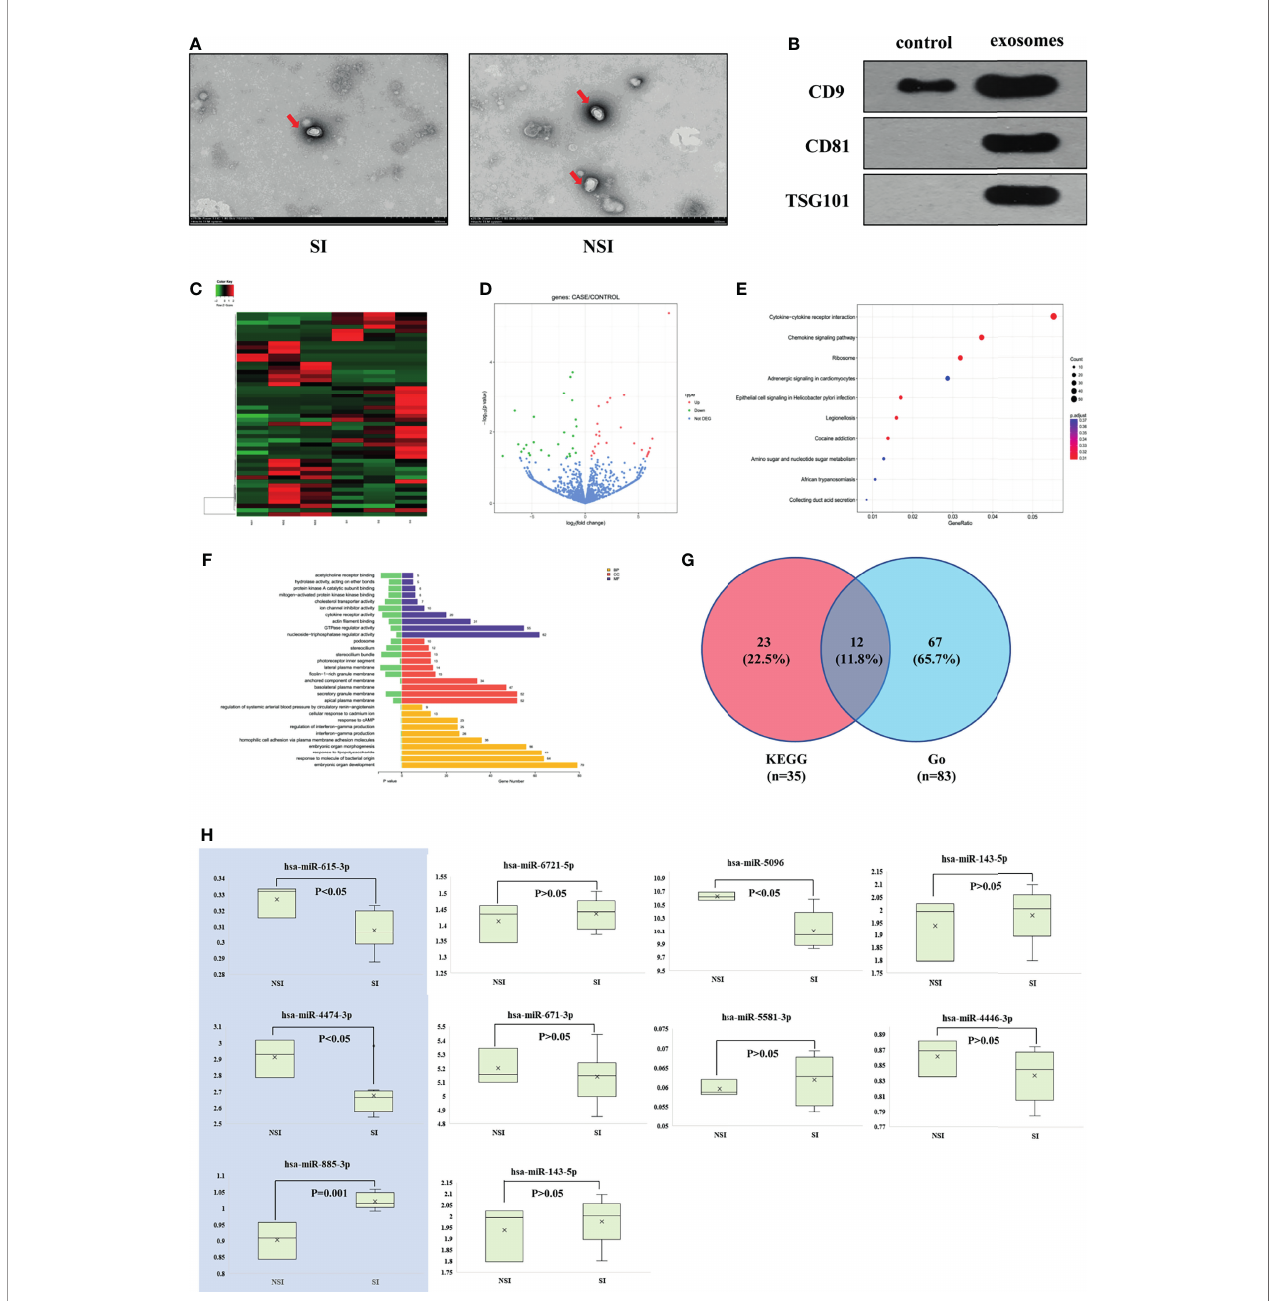
FIGURE 1 | Screening differentially expressed exosome miRNAs. (A) Transmission electron microscopy of plasma exosomes of the SI and NSI groups. (B) Western blot detected exosome-labeled proteins CD9, CD81, and TSG101. (C) Heat map of the cluster analysis of differentially expressed miRNAs among 6 random samples from the SI and NSI groups. (D) Volcano map of differentially expressed miRNAs among 6 random samples from the SI and NSI groups. (E) Scatter plot of KEGG enrichment in differential exosome miRNA target genes. (F) Bar chart of Go enrichment analysis of differential exosome miRNA target genes. (G) Veen analysis of differential exosome miRNA target genes. (H) PCR results of candidate exosome miRNAs among the remaining